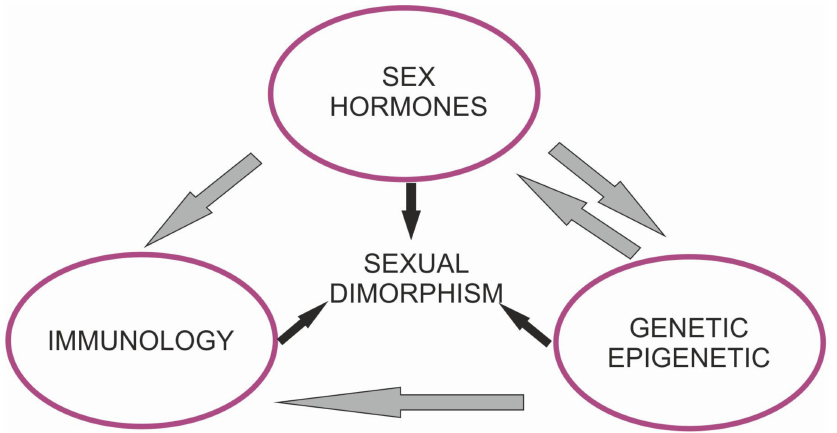
Figure 1. Mechanisms regulating sex specific responses to neurodegenerative diseases and cerebral